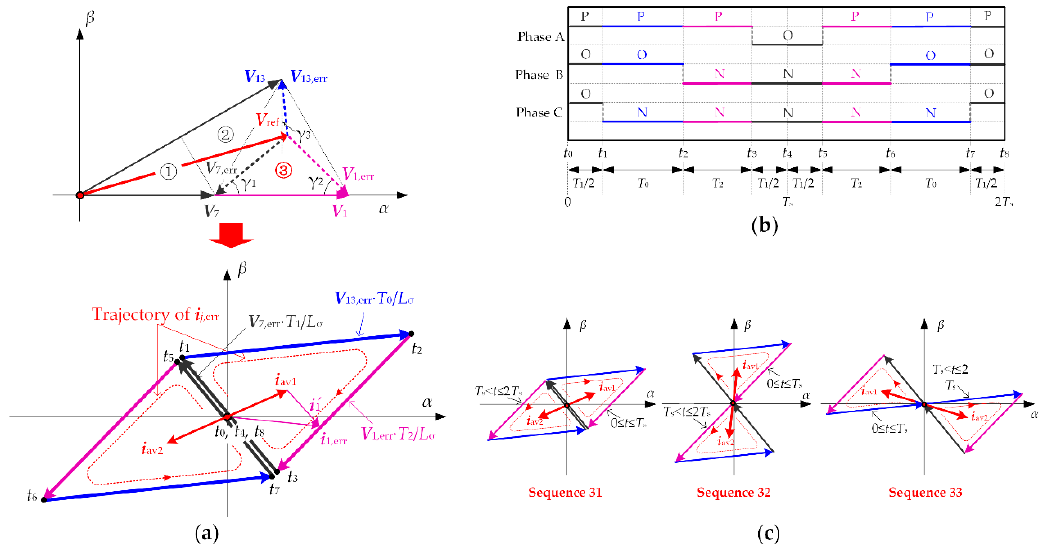
Figure 3. The analysis of output current ripple: ( a ) voltage ripple vectors V 1,err , V 7,err , and V 13,err , and trajectory of the current ripple vector i j ,err in space vector plane; ( b ) switching states of Sequence 31 and corresponding time intervals; ( c ) trajectory of current ripple vector i j ,err for Sequence 31–33 in Triangle ③ of Sector Z 1 .